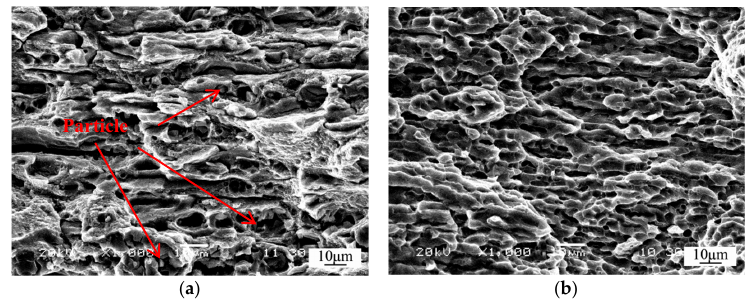
Figure 11. Fracture morphology. ( a ) Fracture of base metal ( b ) Fracture of weld.